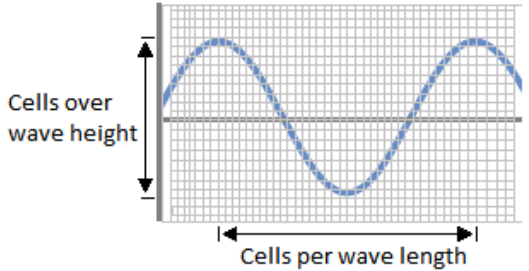
Figure 3. Mesh description definitions (grid resolution and wave surface line not to scale).